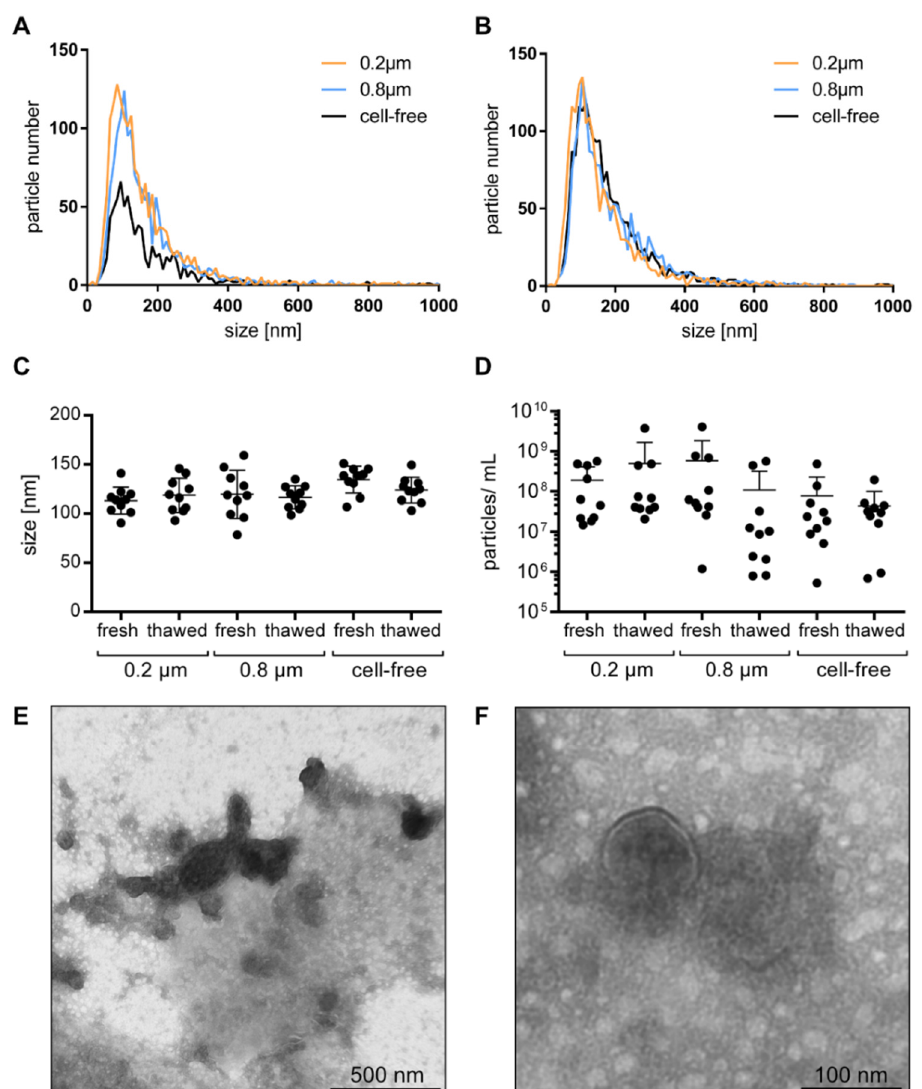
Figure 1. The uEV size, size distribution, and particle concentration: uEV size distribution of nonfiltered, 0.2 µ m, and 0.8 µ m filtered cell-free urine from healthy individuals analyzed by NTA fresh ( A ) and after one week of storage ( B ). Particle size ( C ) and particle number per mL of urine normalized to creatinine ( D ) from fresh and thawed nonfiltered, 0.2 µ m, and 0.8 µ m filtered cell-free urine by NTA, shown as mean ± SD. Visualization of uEVs in cell-free urine by TEM in wide-field with scale bar representing 500 nm ( E ) and in near-field with scale bar representing 100 nm ( F